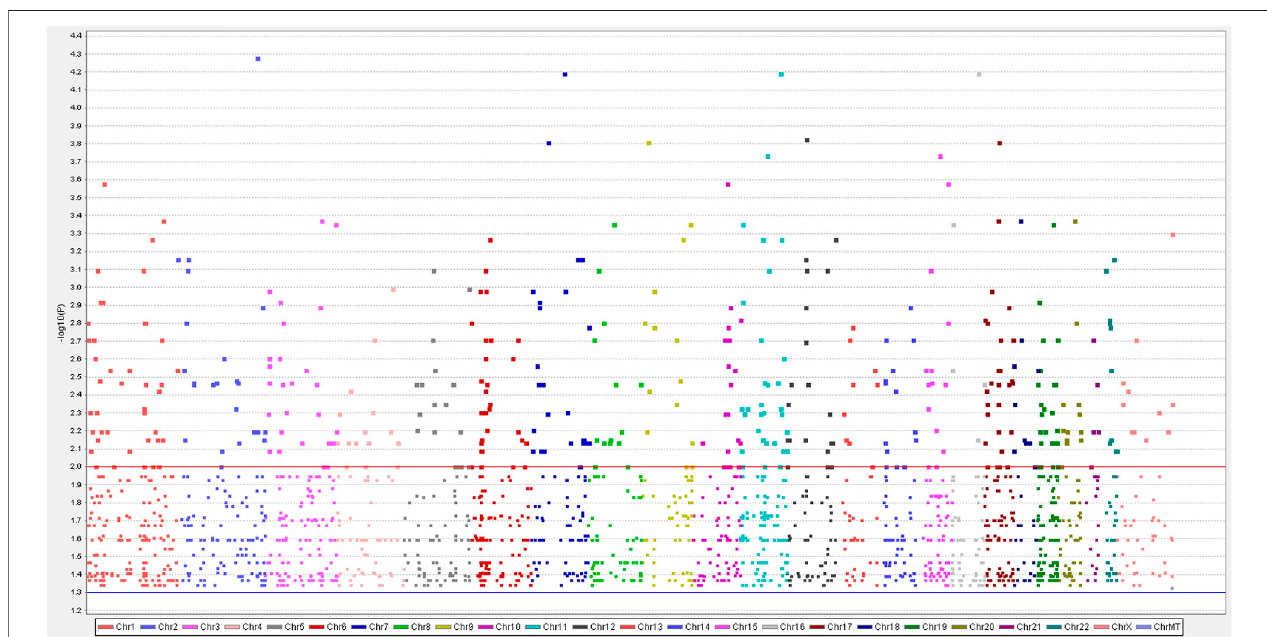
FIGURE 1 | In the aggregate to 2024 single nucleotide polymorphisms (SNPs) were obtained by a genome-wide analysis of four samples of synovial sarcomas. A Manhattanplotindicatesnegativelog-transformed p- valuesofthecase-controlallelefrequencysigni fi canceontheY-axis.Thecolor-codingontheX-axisrepresentsthe number of chromosomes. Gene names indicated by single dots demonstrate SNPs of greatest signi fi cance or with potential disease